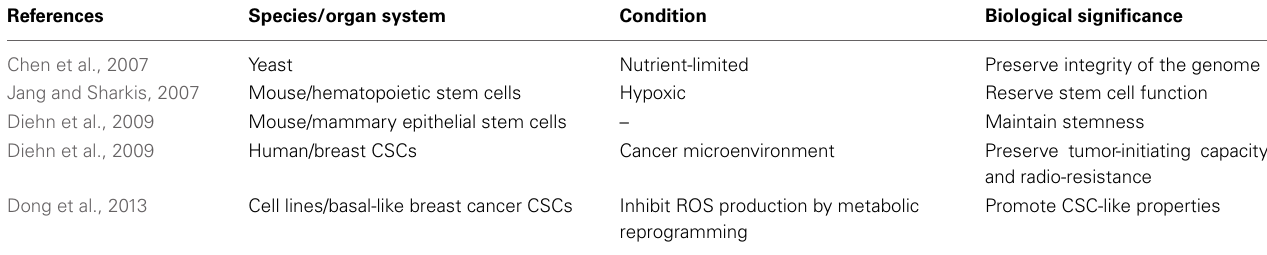
Table 1 | Cellular systems with low intracellular ROS